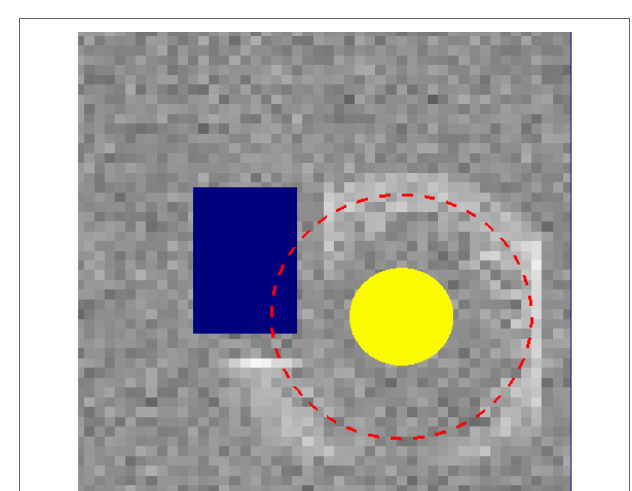
FiGUre 7 | A visualization of the human-to-robot (HtR) transfer empowerment dependent on robot position (dark—low, light—high). This simulation shows a slightly elevated human-to-robot transfer empowerment around the human agent (yellow) at the shutdown distance (red circle). This is because the human can move toward or away from the robot, thereby having the potential to stop the robot. This creates a potential causal flow from the human’s actions to the robot’s sensors, which in this case measure the robot position. Here, the physical proximity of the human allows it to directly influence the robot’s